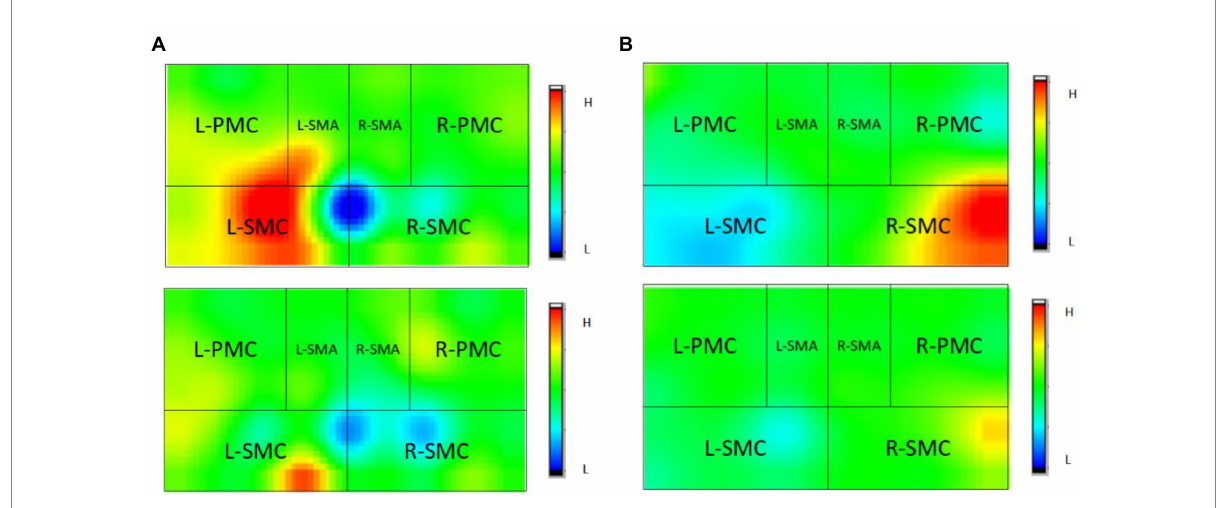
FIGURE 6 Observation of changes of HbO2 concentration in brain of some stroke patients: (A) Control group, (B) Magnetic stimulation group. H, high; L, low; L, left; and R, right. (A) A case of cerebral infarction in the right hemisphere. (B) A case of cerebral infarction in the left